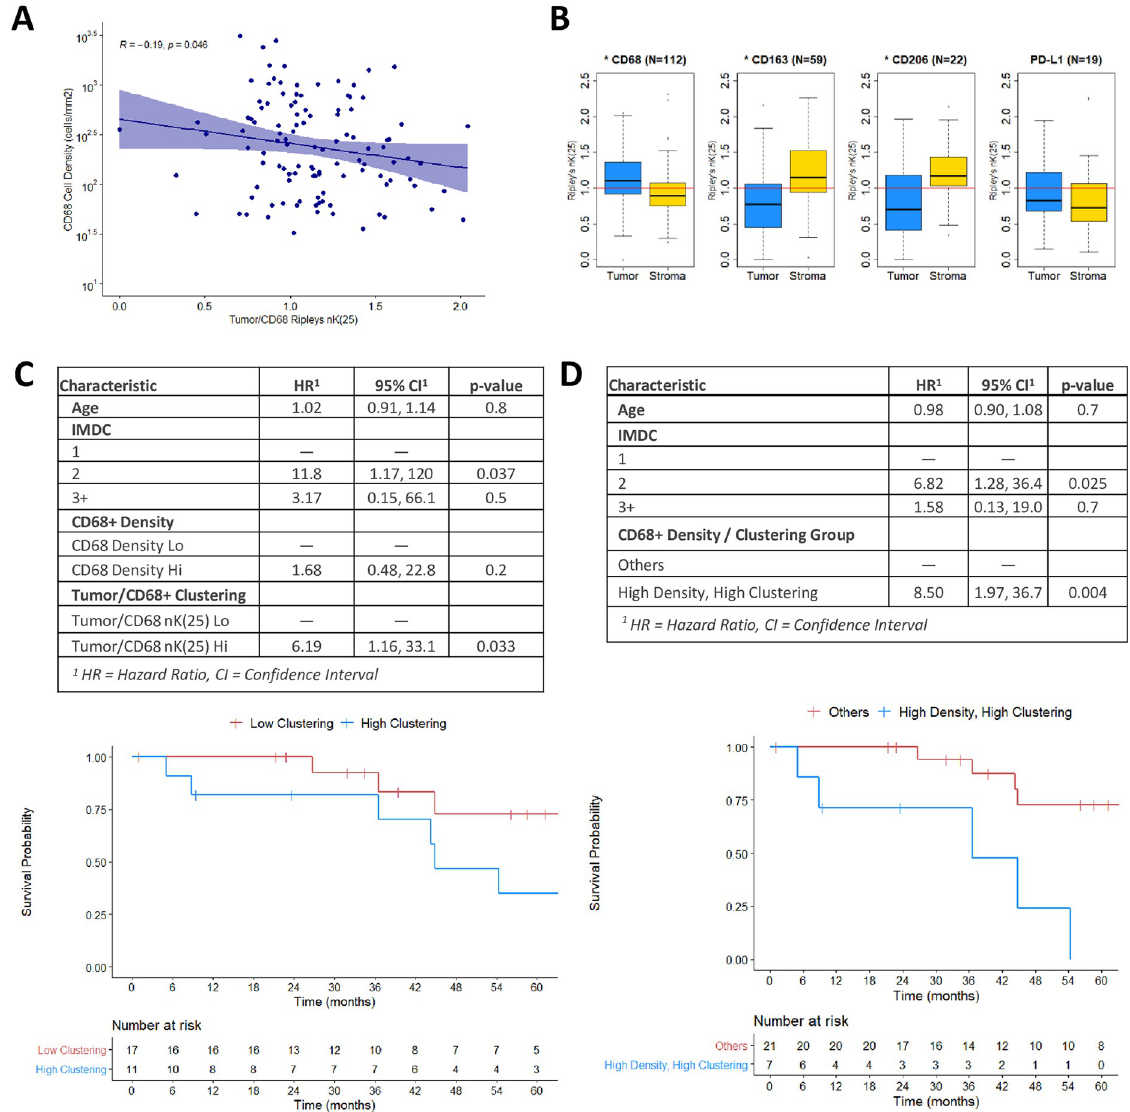
Fig 3. A: Scatter plot and Spearman’s correlation of CD68+ cell density (cells/mm2) and Tumor/CD68+ (nK(25)), per ROI (N = 129, r = -0.19, p = 0.046). B: Boxplot diagrams of Ripley’s nK(25) values for Tumor/CD68+, Stroma/CD68+, Tumor/CD163+, Stroma/CD163+, Tumor/CD206+, Stroma/CD206+, Tumor/PDL1+, and Stroma/PDL1+, for all ROIs (N = 129). nK(25) values > 1 indicate cellular clustering, and values < 1 indicate cellular dispersion. Asterix in plot title denotes Wilcoxon test p < 0.05. C: Multivariable Cox regression for OS, using CD68+ cellular density and Tumor/CD68+ nK(25) as separate covariates, with associated KM estimates for high versus low Tumor/CD68 + nK(25). D: Multivariable Cox regression for OS, stratifying patients who had high CD68+ cellular density and high Tumor/CD68+ nK(25) versus other patients, with associated KM